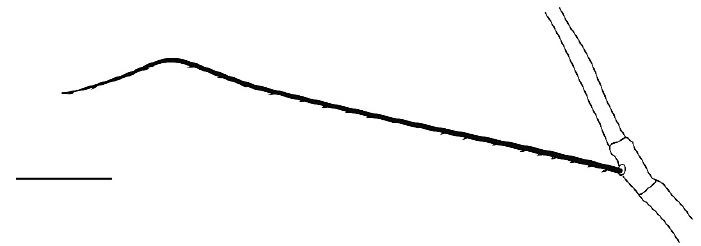
Figure 6. Neophyllobius combreticola . Female. Genu I. Scale bar: 50 μ m.